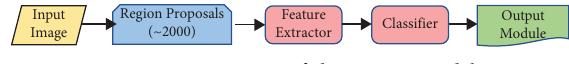
Figure 1: Structure of the RCNN